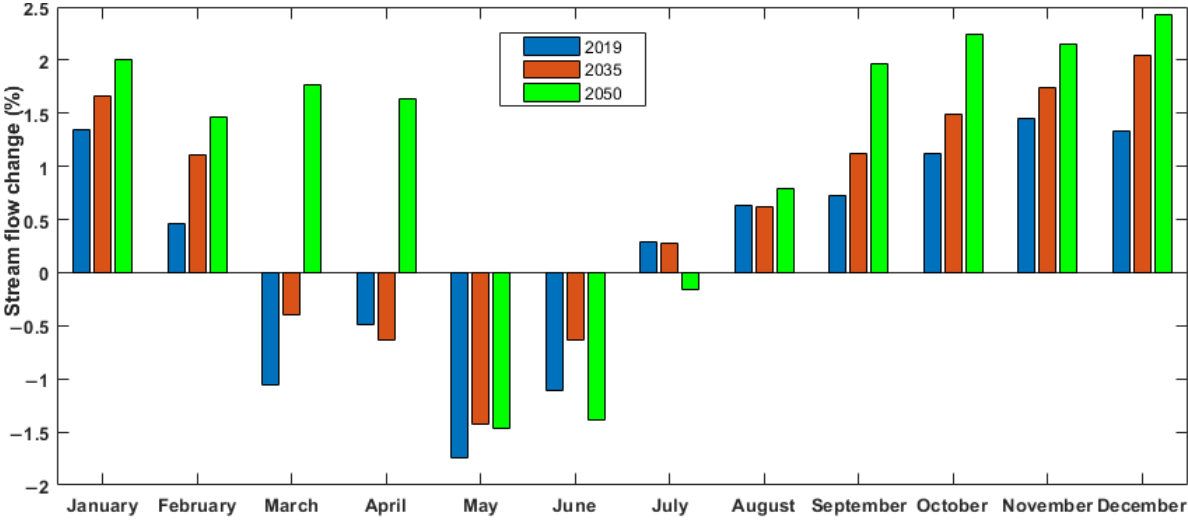
Figure 6. Average monthly stream flow change under land use land cover scenarios.